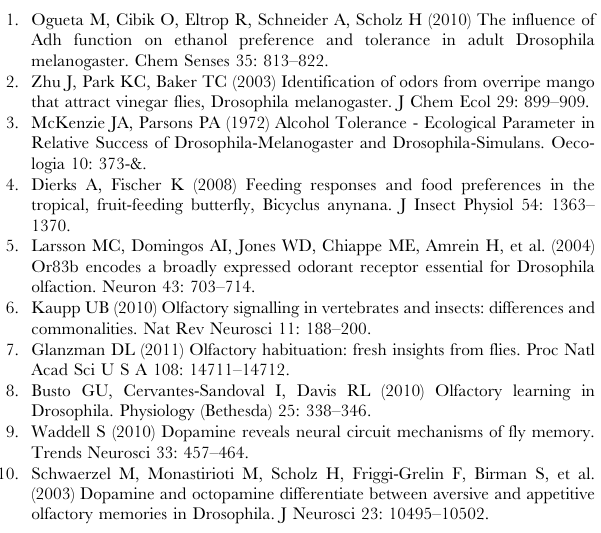
(TIF) Figure S2 Feb15 -GAL4 drives expression the ventral neurons. (TIF) Figure S3 6.2 -Tbh-GAL4 drives expression in the VUMa4 neuron. (TIF) Figure S4 The expression of Tdc2-GAL4 line does not match all TbH positive neurons in the thorax. (TIF) Figure S5 The Tdc2-GAL4; Cha-GAL80 drives expression in a subset of TbH positive neurons. (TIF) Figure S6 NP-7088 -GAL4 dependent expression of TbH restores preference of Tbh nm18 mutants. (TIF) Table S1 Concentration independent loss of preference in Tbh nm18 . (TIF) Table S2 TbH expression in the adult head. (TIF) Table S3 Expression patterns of GAL4 driver lines in the thorax in comparison to